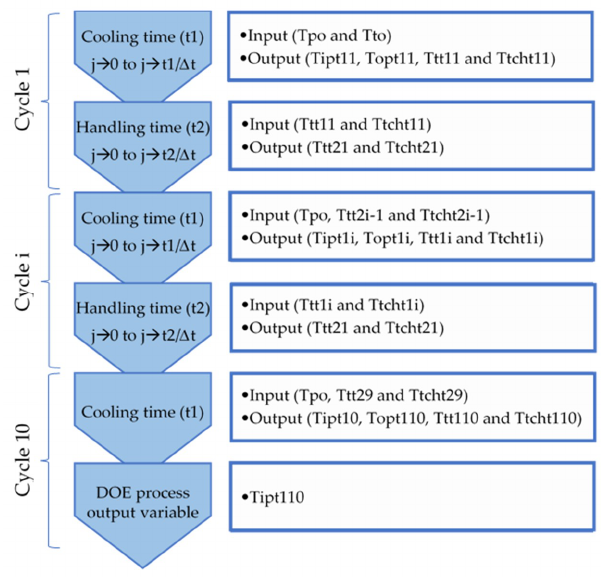
Figure 4. Iterative one-dimensional heat transfer model.